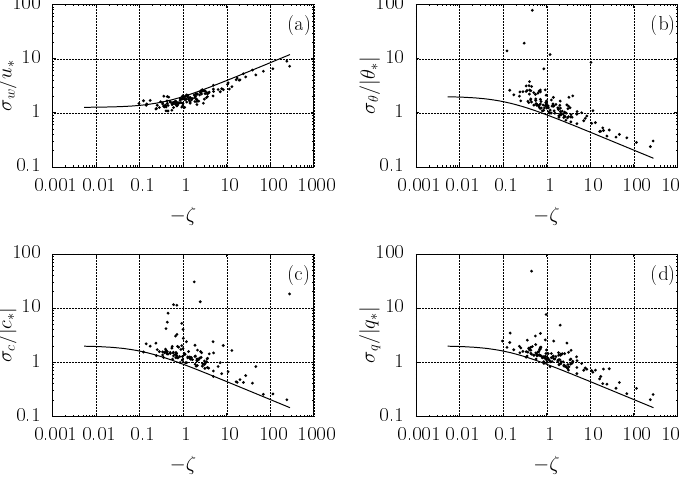
Figure 5. Dimensionless standard deviation for vertical velocity (a) , temperature (b) , CO 2 (c) , and water vapor (d) : 81.6m.